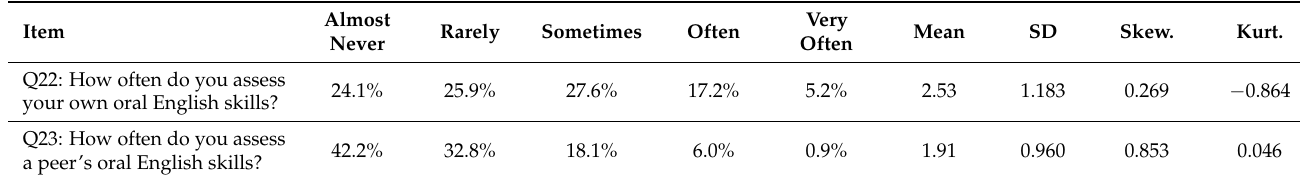
Table 4. Students’ participation in self- and peer